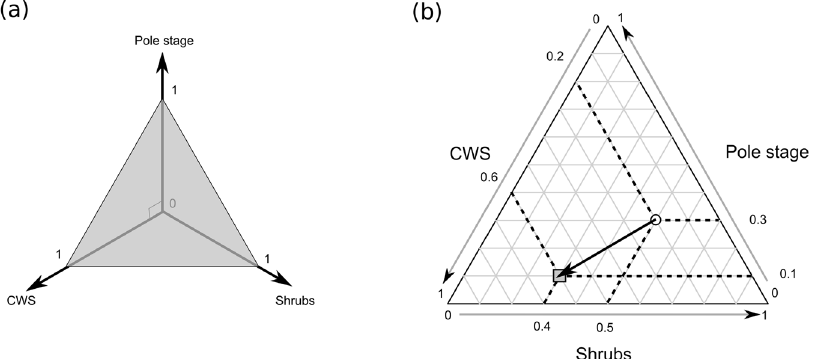
Figure 5. Visualization of the marginality vectors in the ecological space defined by three habitat types. ( a ) Each habitat type defines a dimension in the ecological space. Every habitat composition (whether habitat use or availability) corresponds to a vector of three proportions. This vector defines a point in the ecological space. However, because the cumulative proportions of the three habitat types sum to 1, the possible points are consistently located in a two-dimensional triangular subspace, called ecological triangle in the text (grey triangle). ( b ) Therefore, it is possible to plot every possible habitat composition on this ecological triangle. This ternary plot is an exact representation of the ecological triangle. For illustration, we represented a female roe deer with a home range covered with 50% of shrubs, 30% of pole stage and 20% of coppice with standards (CWS), which spends 40% of its time in the shrubs, 10% in the pole stage and 60% in the CWS. The arrow connecting the available point (white circle) to the used point (grey square) is the marginality vector of the female roe